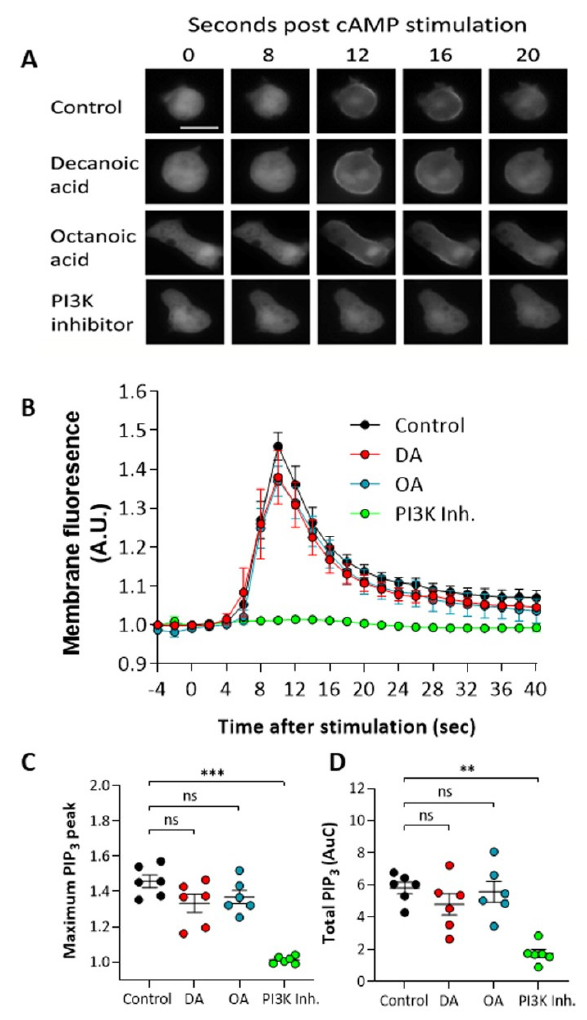
Figure 3. Medium-chain fatty acids do not reduce transient PIP 3 production in Dictyostelium at concentrations that trigger autophagy. To visualize PIP 3 production, cells expressing PHcrac-GFP in early development were treated with decanoic acid or octanoic acid (both at 60 μ M, 4 h), PI3K inhibitor (100 μ M LY294002, 15 min), or solvent control (DMSO) and stimulated with 1 μ M cAMP to trigger production of PIP 3 visualized by transient movement of PHcrac-GFP to the membrane. ( A ) Cells show transient movement of PHcrac-GFP to cell membranes, reflecting induction of PIP 3 production, and ( B ) membrane fluorescence was quantified normalized to whole cell fluorescence, and ( C ) maximum membrane fluorescence (PIP 3 production) and ( D ) total area under the curve (total PIP 3 production) were compared between treatments. Data represent mean and SEM from six inde- pendent experiments (three individual cells were analyzed per experiment). Scale bar represents 10